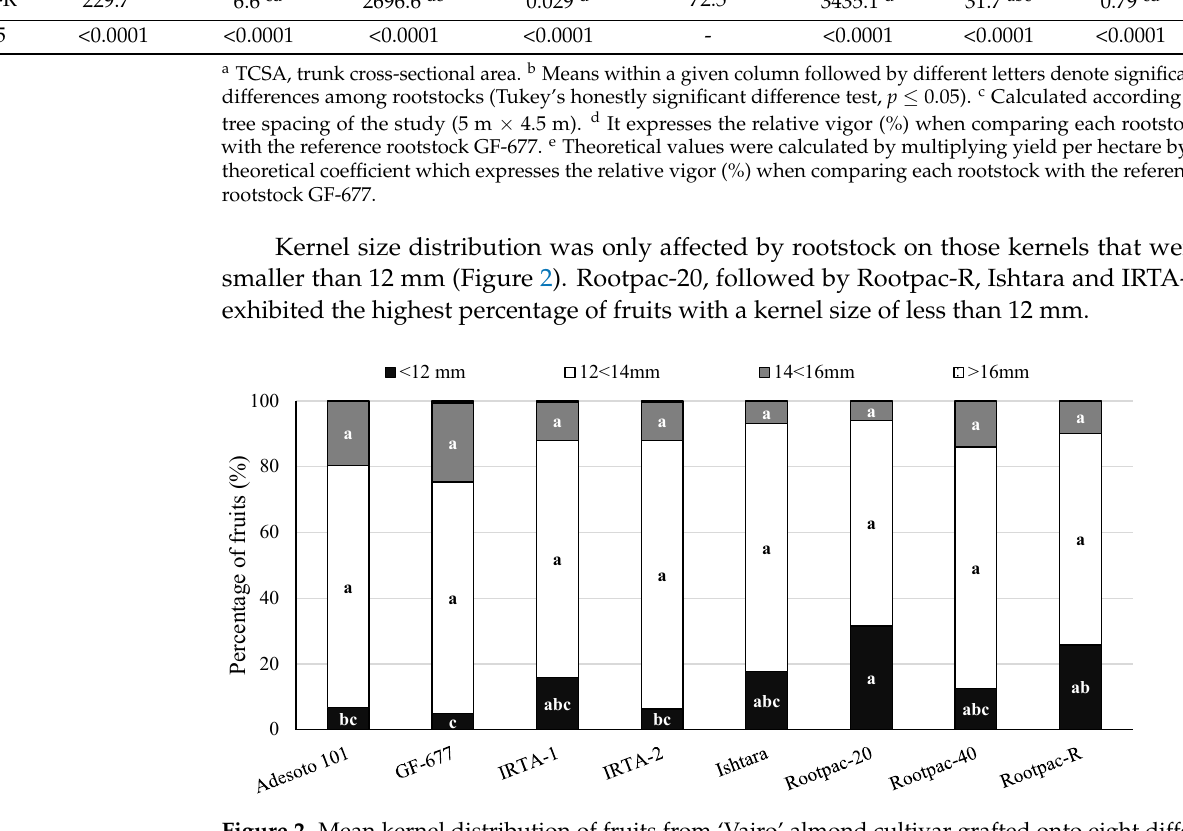
Figure 2. Mean kernel distribution of fruits from ‘Vairo’ almond cultivar grafted onto eight different Prunus rootstocks at the IRTA’s Lleida Experimental Station (Borges Blanques, Lleida) in the eighth crop year (2017). For each distribution, different letters denote significant differences among rootstocks (Tukey’s honestly significant difference test, p ≤ 0.05).